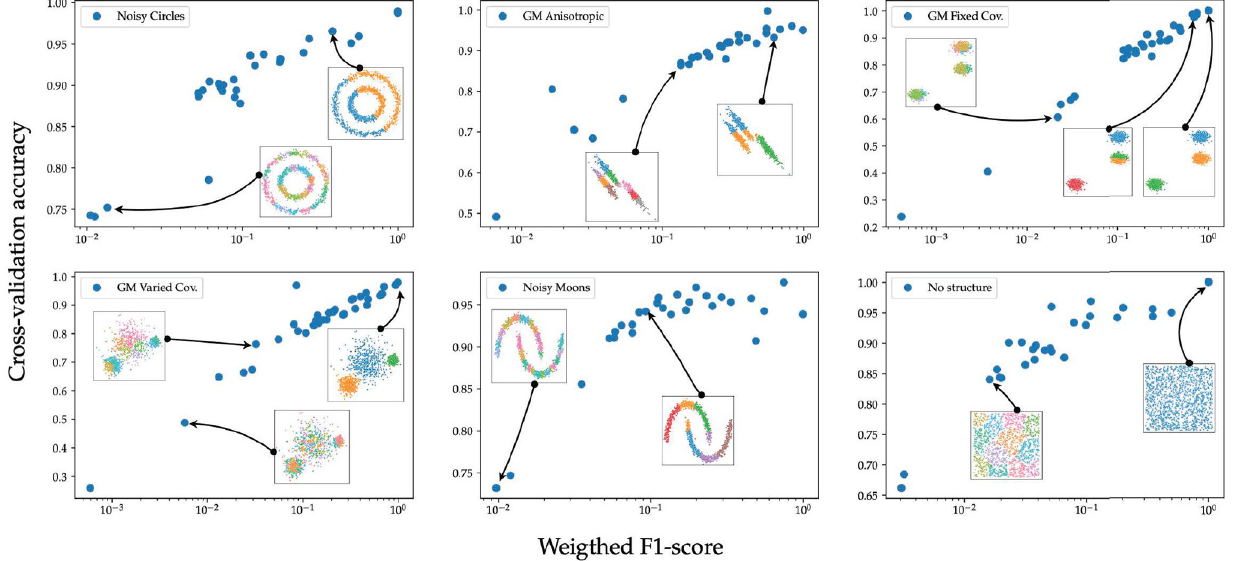
Fig 2. Out-of-sample accuracy vs. weighted F -score (comparison to ground-truth) for various clustering algorithms. We used out-of-the- box clustering algorithms DBSCAN , spectral clustering , K -means and Meanshift with various hyper-parameters and clustered 6 different benchmark two- dimensional datasets: Noisy Circles, Gaussian mixtures with different covariance structures, non-convex clusters (Noisy Moons) and a random noise map (No Structure). These datasets were taken from scikit-learn clustering methods as benchmark datasets (see S1 Methods for more details). The out-of-sample accuracy is computed by training a random forest classifier with 100 estimators on the clustering labels provided by the clustering algorithms. We use a 80/ 20 train/test split to train the classifiers and evaluate the out-of-sample error. Notice that the F-score and out-of-sample accuracy as measured are monotonically